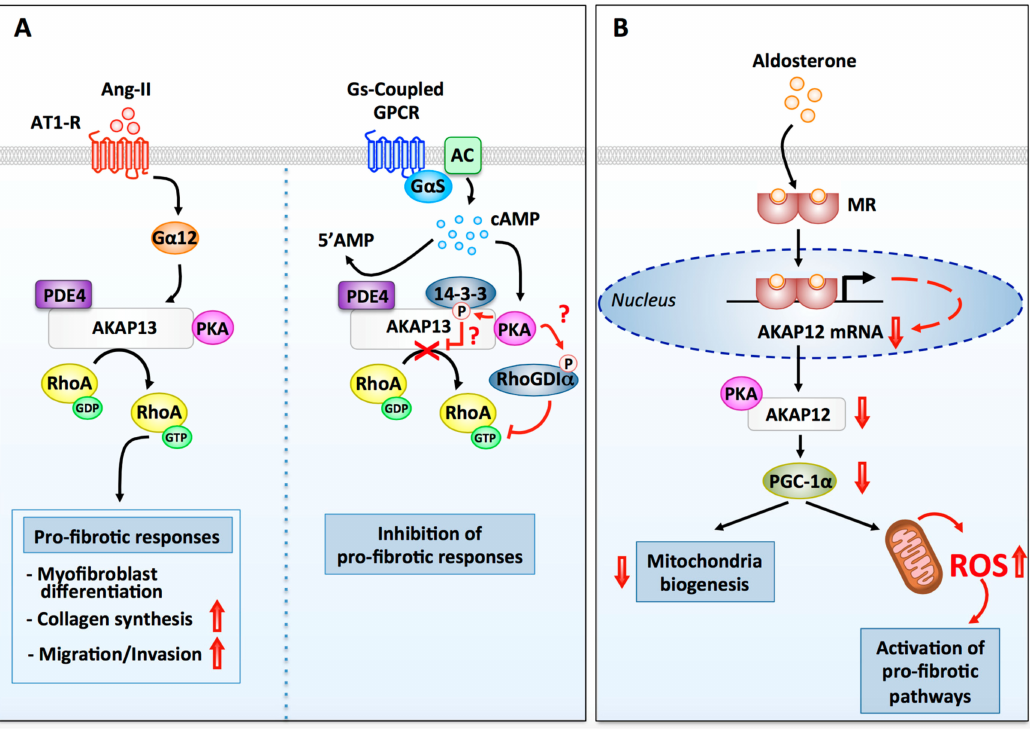
Figure 3. Regulation of fibrotic signaling pathways by PKA and AKAPs. ( A ) AKAP13-dependent modulation of fibrotic responses in ventricular fibroblasts. (Left side) Stimulation of AT1-Rs by Ang-II enhances AKAP13 Rho-guanine nucleotide exchange factor (GEF) activity through a signaling pathway that involves G α 12 . Active RhoA released from AKAP13 promotes several pro-fibrotic responses including myofibroblast di ff erentiation, collagen production, TGF β 1 production, migration, and invasion. (Right side) Phosphorylation of AKAP13 by anchored PKA is known to promote 14-3-3 recruitment and inhibition of AKAP13 RhoGEF activity. PKA has also been shown to phosphorylate Rho guanine nucleotide dissociation inhibitor α (RhoGDI α ), which favors its association with RhoA-GTP and RhoA inhibition. It remains to be established whether AKAP13-anchored PKA can mediate these two inhibitory responses in cardiac fibroblasts. Termination of cAMP signaling is mediated AKAP13-anchored PDE4. ( B ) AKAP12-dependent regulation of reactive oxygen species (ROS) production in cardiac fibroblasts. Binding of aldosterone to mineralocorticoid receptors induces their nuclear translocation and the activation of a transcriptional response that results in the downregulation of AKAP12 mRNA and protein. Suppression of AKAP12 expression leads to the downregulation of PGC-1 α . This inhibits mitochondrial biogenesis and promotes the production of ROS and oxidative stress, a potent activator of pro-fibrotic signaling